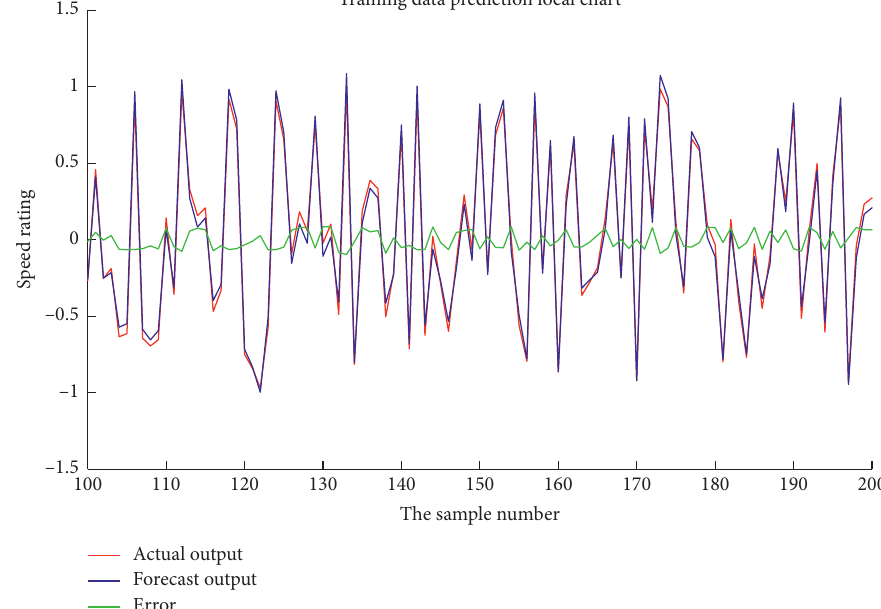
Figure 8: Traditional T-S fuzzy neural-network training data prediction local